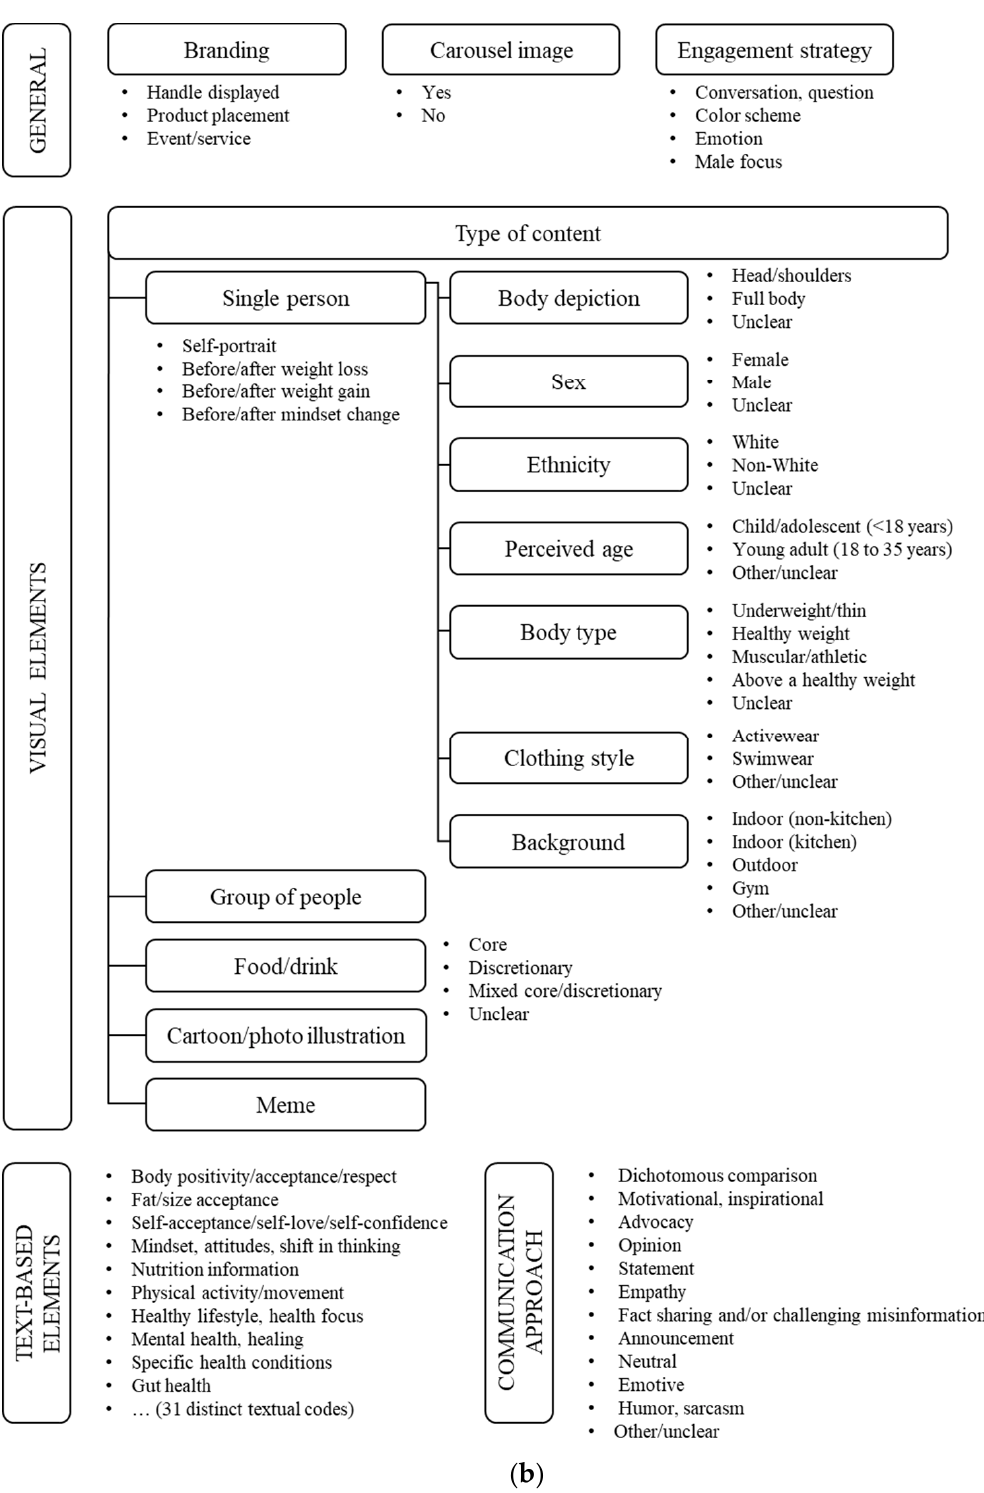
Figure 1. Extracts of the coding frameworks developed for ( a ) #mindfuleating and ( b )